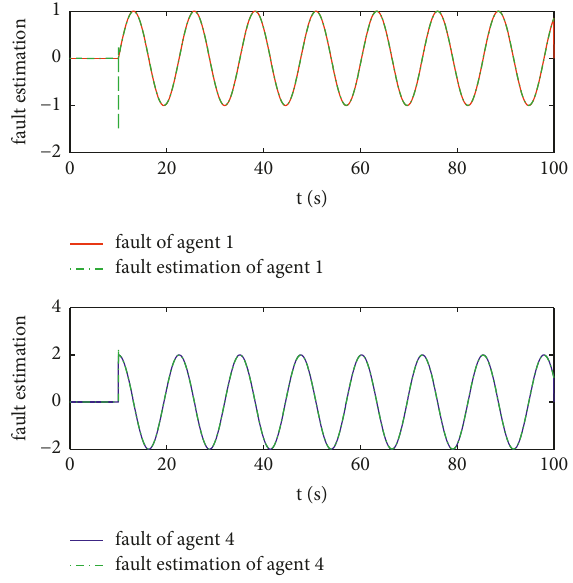
Figure 3: Time-varying fault and fault estimation.